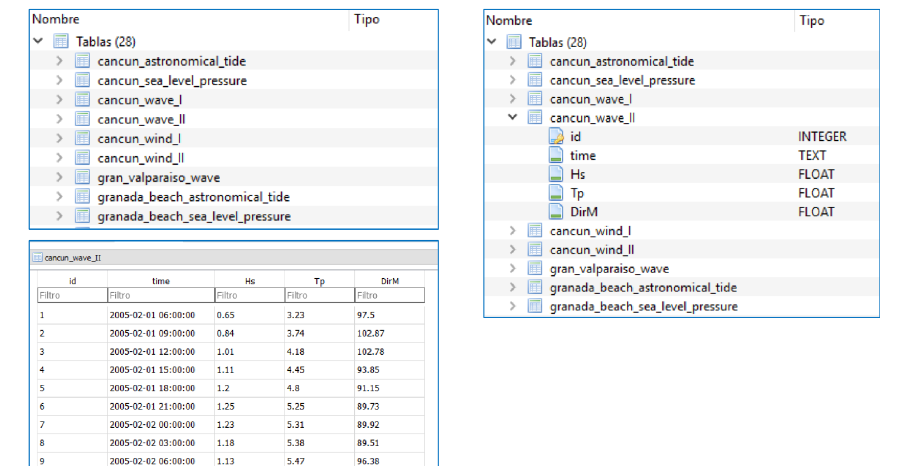
Figure 6. Automatically-generated